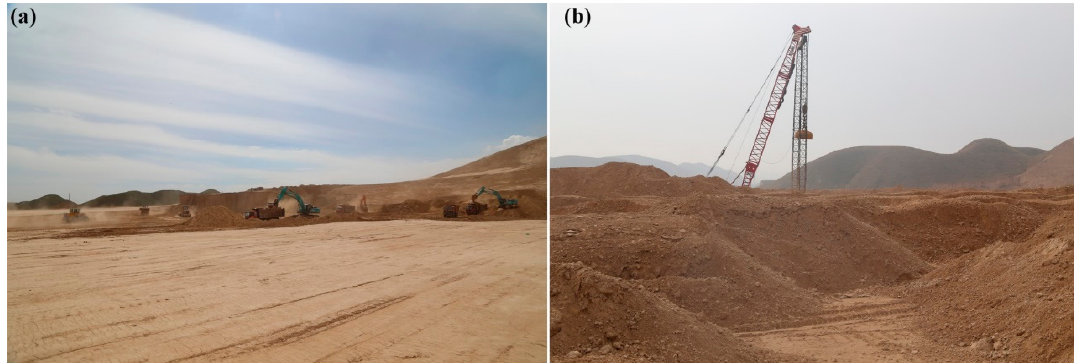
Figure 2. Land creation in LZND: ( a ) infilling work in the loess hilly region; and ( b ) repeated dynamic compaction during the infilling process.